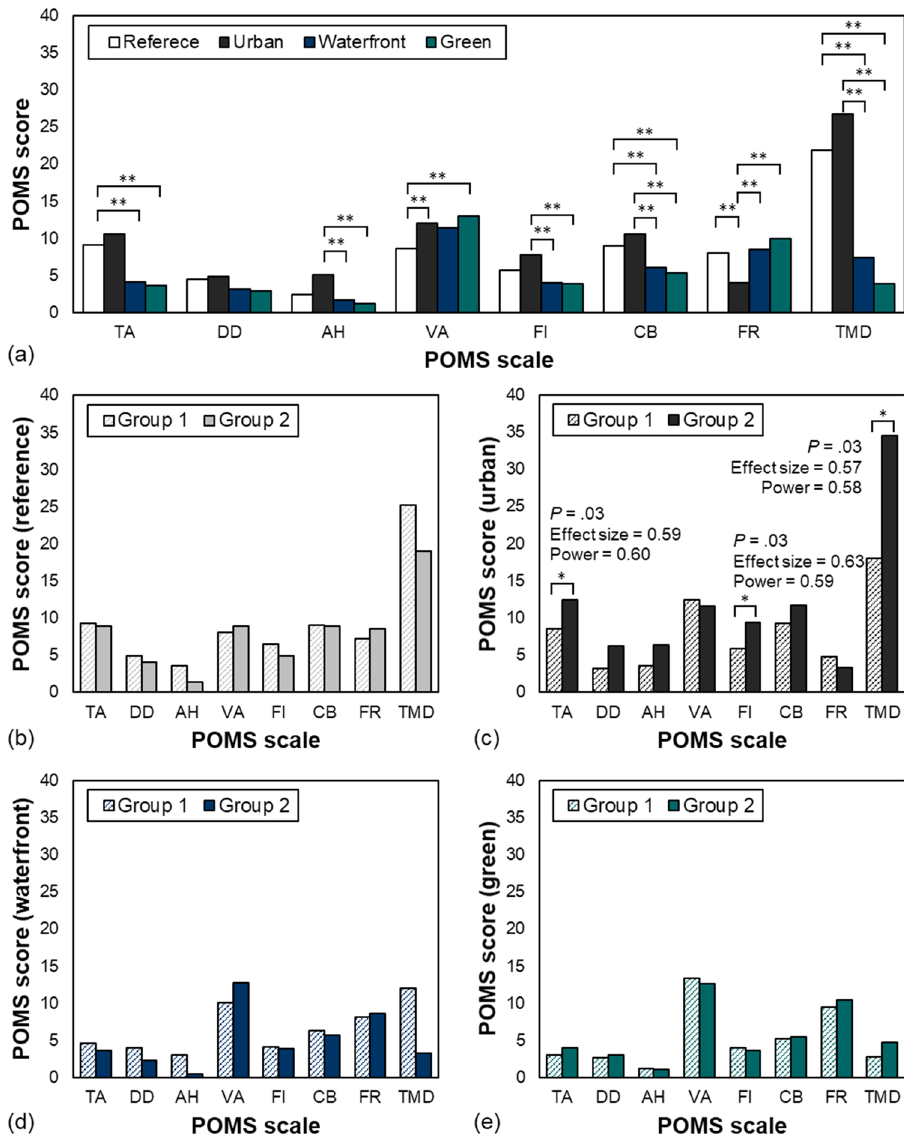
reference with different groups, ( c ) K-POMS difference in urban with different groups, ( d ) K-POMS difference in waterfront with different groups, ( e ) K-POMS difference in green with different groups. Tension-Anxiety (TA), Depression-Dejection (DD), Anger-Hostility (AH), Vigor-Activity (VA), Fatigue-Inertia (FI), Confusion- Bewilderment (CB), Friendliness (FR), Total Mood Disturbance (TMD; ** P -value < .001, * P -value <